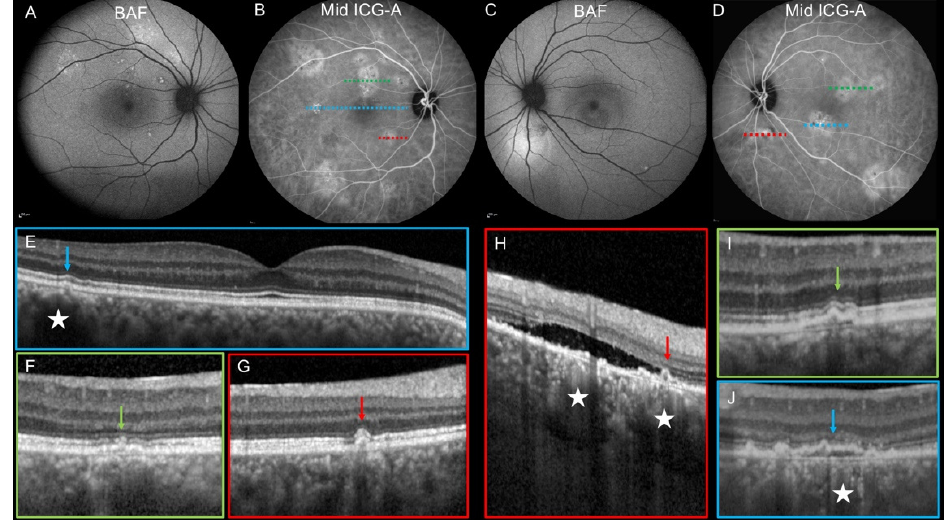
Figure 2. Multimodal imaging of a 37-year-old man with bilateral chronic central serous chorioretinopathy. ( A , B , E – G ). Right eye. ( A ). Blue-light fundus autofluorescence (BAF) shows a superior hyper-autofluorescent area consistent with previous serous retinal detachments. ( B ). Mid-phase indocyanine green angiography (ICG-A) shows multifocal mid-phase hyperfluorescent plaques (MPHP) without retinal pigment epithelium (RPE) damages detected on BAF. ( E ). The horizontal OCT B-scan passing through the fovea shows a RPE bulge at the level of the temporal MPHP (arrow). ( F , G ). The horizontal OCT B-scan passing through the MPHP (green and red dotted lines) shows an irregular pigment epithelium detachment (PED, ( F ), green arrow) and a RPE bulge (( G ), arrow). ( C , D , H – J ). Left eye. ( C ). BAF shows a hyper-autofluorescent area inferior to the optic disc that corresponds to a subretinal detachment (SRD, ( H )). ( D ). Mid-phase ICG-A shows multifocal MPHP. ( H ) The horizontal OCT B-scan passing through the MPHP (red dotted-line) shows a serous retinal detachment associated with RPE irregularities (red arrow) and dilated choroidal vessels (stars). ( I , J ). The horizontal OCT B-scan passing through the MPHP (green and blue dotted-line) shows small irregular PED (green arrow and blue arrow). A dilated choroidal vessel is visualized behind the PED (star, ( J )).